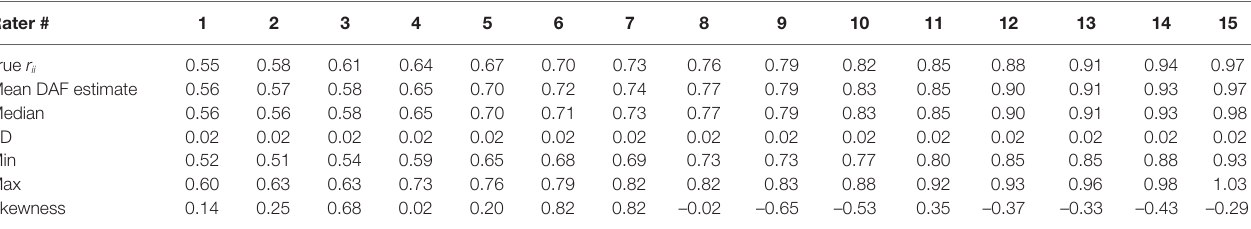
Each statistic of the distribution of the DAF estimates is based on 91 triads of correlations (see text).